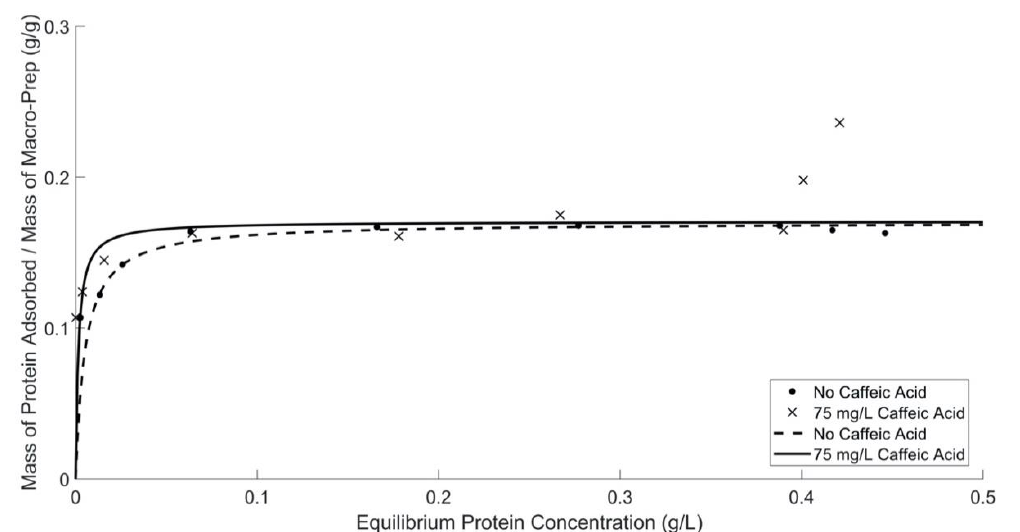
Figure 4. Macro-Prep ® ’s protein adsorption ability in model wine solutions with and without the addition of caffeic acid by using the Bradford protein assay and UV-Vis spectrometer at 595 nm. Caffeic acid fit excludes the two data points at high equilibrium protein concentrations, >0.4 (g BSA)/L. When fitting only these data, the adsorption capacities are not significantly different from each other.